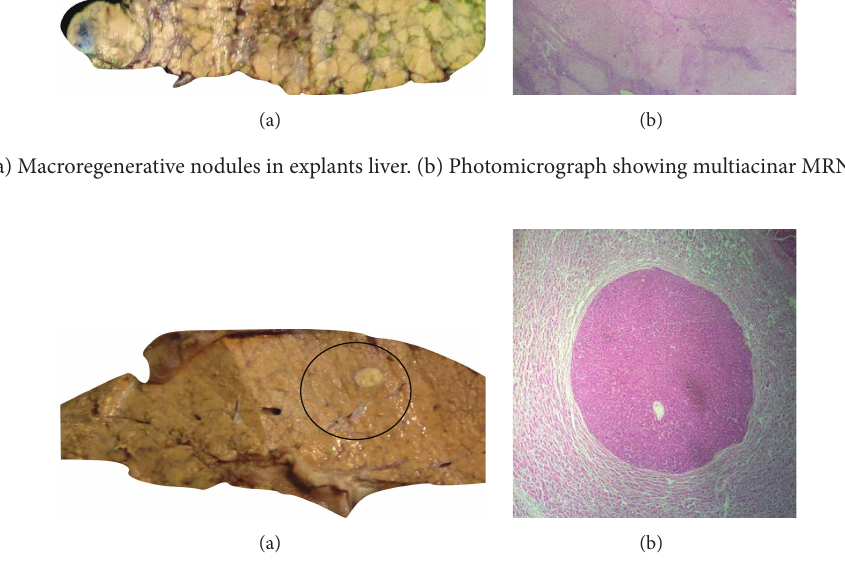
Figure 3: (a) Dysplastic nodule in explant liver. (b) Photomicrograph showing dysplastic nodule with small cell change (H&E ×